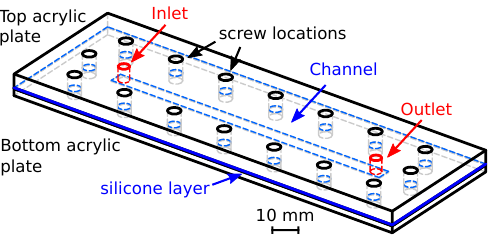
Figure 2. The schematic of the microfluidic chip. The rectangular channel was cut in a thin, approximately 0.3mm thick silicone layer. The top and bottom surfaces were encapsulated by 4 and 2mm thick acrylic plates, respectively. The layers were held together by screws. The channel had a width of 4mm. The inlet and outlet ports were drilled through the top acrylic plate.